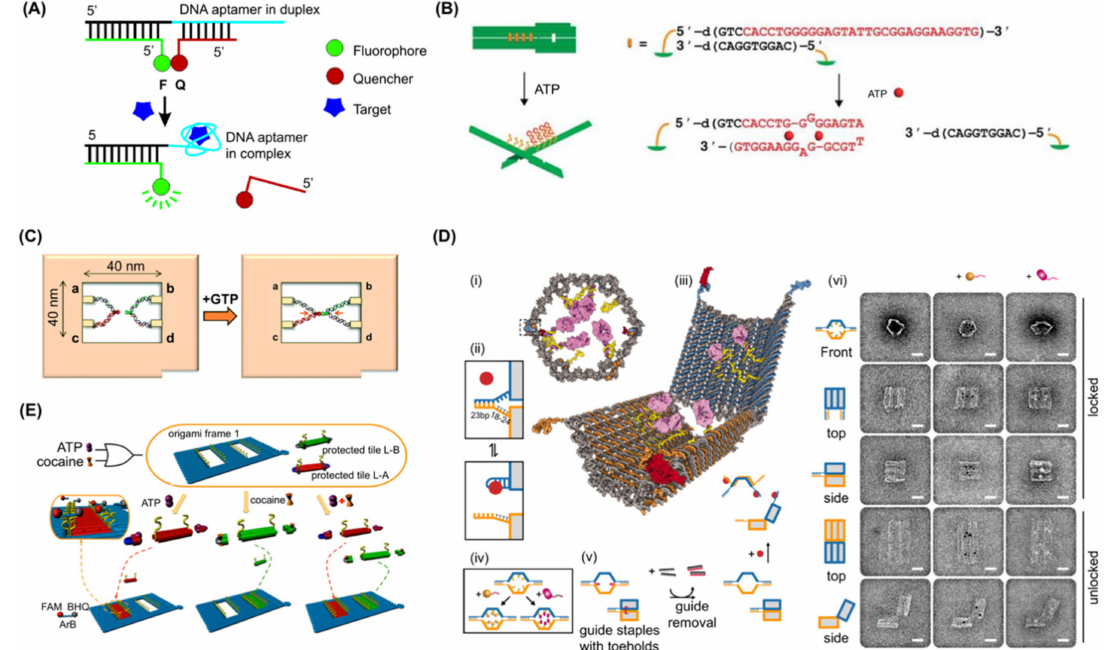
Figure 3. Examples of aptamer use in controlling DNA origami structural change. ( A ) Schematic for designing aptamer-based fluorescent reporters that function by switching structures from DNA/DNA duplex to DNA/target complex. Adapted with permission from Nutiu et al. [98]. Copyright (2003) American Chemical Society. ( B ) Key and lock system to detect ATP using aptamer-based elements. Adapted from Kuzuya et al. [78]. ( C ) Schematic of the system for investigating the interaction of kissing RNA aptamers using a DNA frame. Incorporation of the aptakiss into the a–c site and KG51 or GTPswitch into the b–d site in the DNA frame. When the GTPswitch is incorporated into the DNA frame, GTP should induce conformational change from the double-loop to the X-shape. From Takeuchi et al. [85]—Reproduced by the permission of The Royal Society of Chemistry. ( D ) ( i ) Schematic of the front view of a closed nanorobot loaded with a protein payload; ( ii ) the DNA aptamer (blue) and a partially complementary strand (orange) make the aptamer lock. The lock can be stabilized in a dissociated state by its antigen key (red); ( iii ) nanorobot opened by protein displacement of aptamer locks. The two origami domains (blue and orange) are constrained in the rear by scaffold hinges; ( iv ) Payloads (gold) and antibody Fab’ fragments (magenta) can be loaded inside the nanorobot; ( v ) Front and side views show guide staples (red) bearing 8-base toeholds that aid the assembly of the nanorobot. After folding, guide staples are removed by the addition of fully complementary oligos (black). Nanorobots can be subsequently activated by interaction with antigen keys (red); ( vi ) TEM images of robots in closed and open conformations. From Douglas et al. [70]. Reprinted with permission from the American Association for the Advancement of Science. ( E ) Schematic illustration of an “OR” gate using ATP and cocaine as two independent inputs to trigger the filling patterns. In the locking step, both tile A or B can be deactivated by hybridizing with the protector strands PA or PB, which contain aptamer-recognizing sequences of ATP and cocaine in the middle region, respectively. In the unlocking step, the protector strands (PA or PB) at the ends of the L-A or L-B can be removed by adding the aptamer target (ATP or cocaine). Adapted with permission from Yang et al. [79]. Copyright (2016) American Chemical